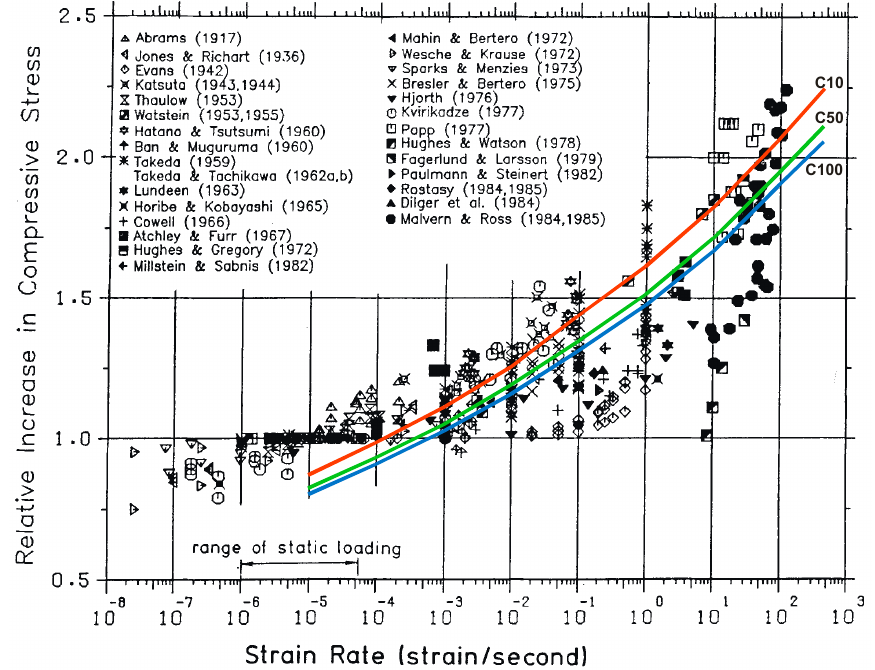
Figure 8. The results of the proposed dynamic strength criterion of concrete on the background of the results for the uniaxial compression presented by Bischoff and Perry [48].